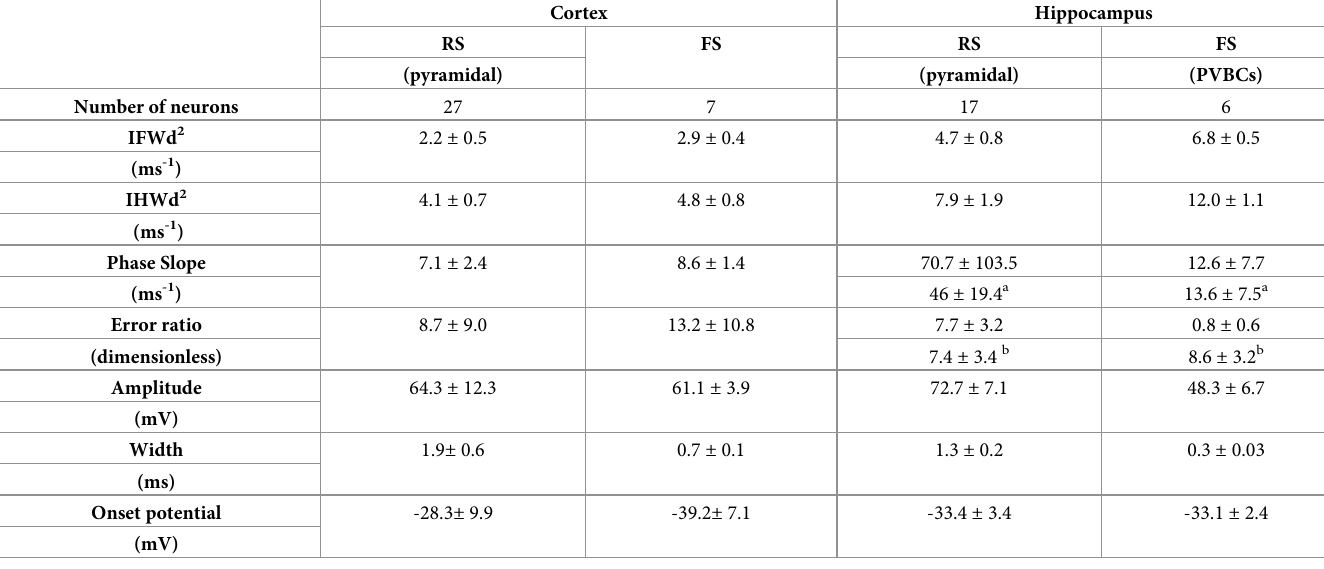
shows a statistically significant difference between superficial and deep neurons using pooled statistics. Thus, all the hippocampal pyramidal neurons, despite their varying location, were treated as the same cell population (Table 1). Table 1. Electrophysiological properties using conventional mean and standard